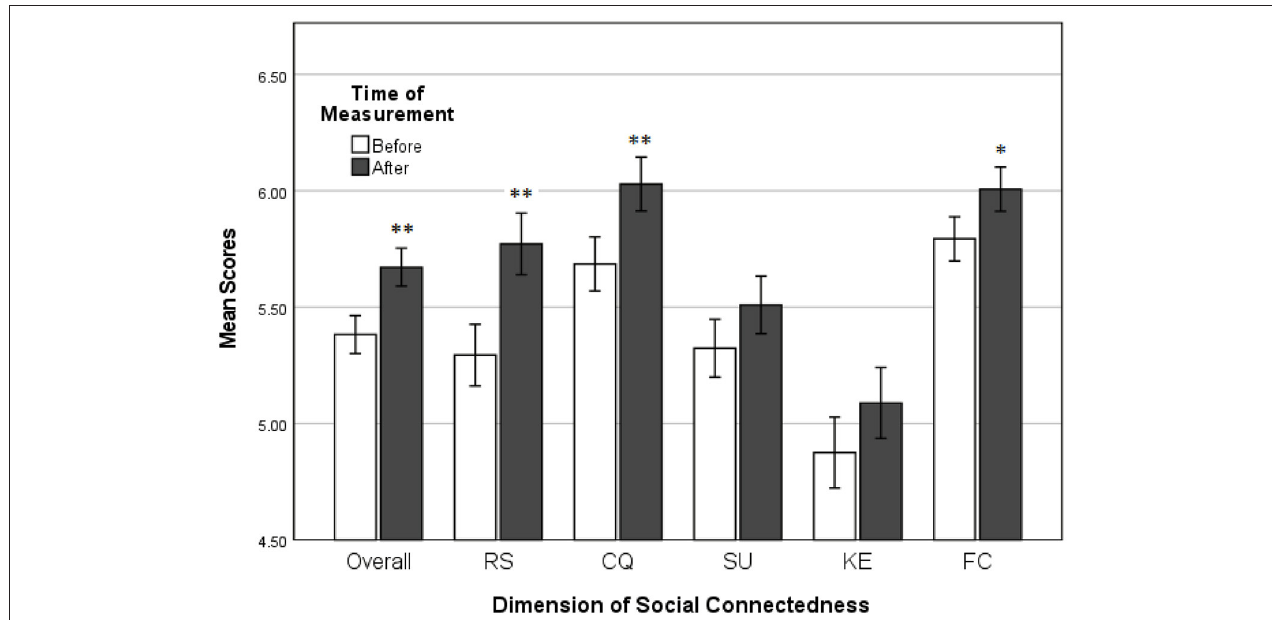
FIGURE 2 | The mean scores of couples on the Social Connectedness Questionnaire, as a function of time of measurement (before and after using MST technology). Answers ranged from 1 (low social connectedness) to 7 (high social connectedness). α = 0.05. Couples’ scores on all dimensions of the SCQ increased after 2 weeks of using MST technology. Significant increases are indicated by asterisks, where * p < 0.05; ** p <